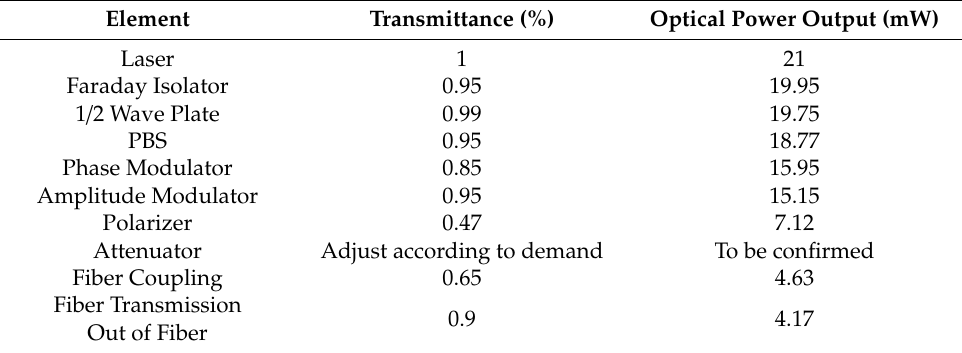
Table 1. Beam power passing through each part of the EMLMA.